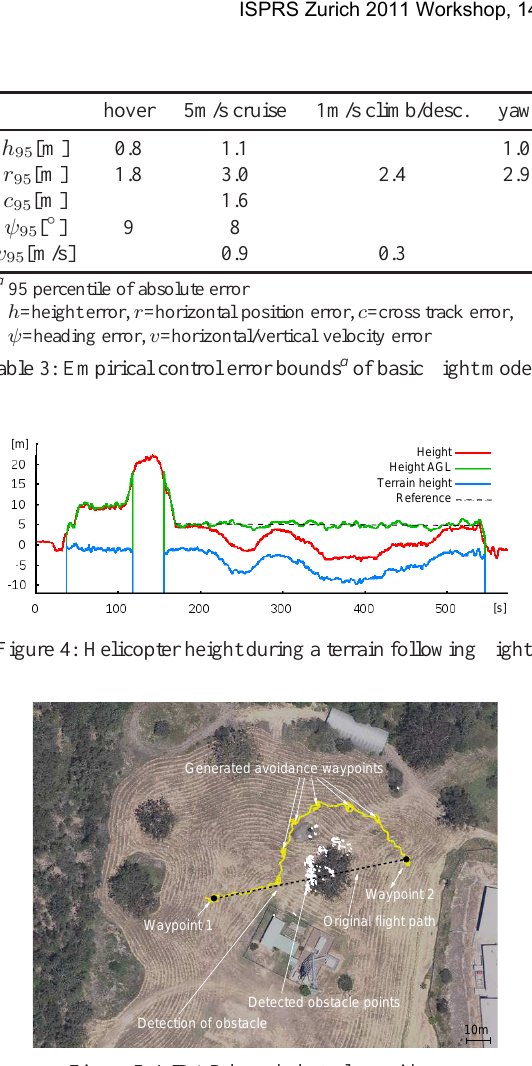
Figure 5: LIDAR based obstacle avoidance.